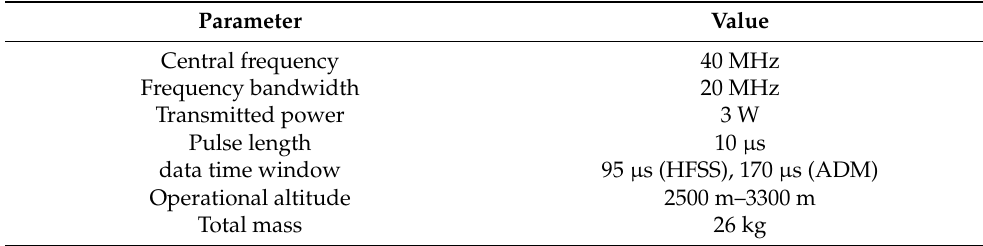
Table 1. Main MOSIR parameters in the ground experiment.